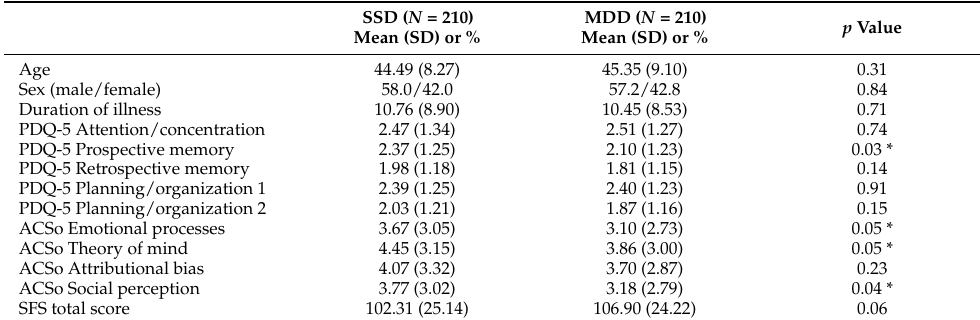
Table 1. Demographics and clinical characteristics of patients with schizophrenia spectrum disorders or major depressive